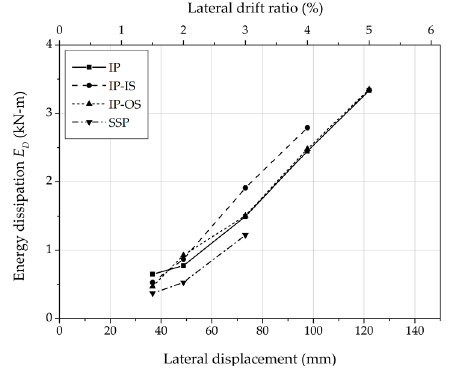
Figure 11. Variation in the energy dissipation per load cycle with drift ratio.